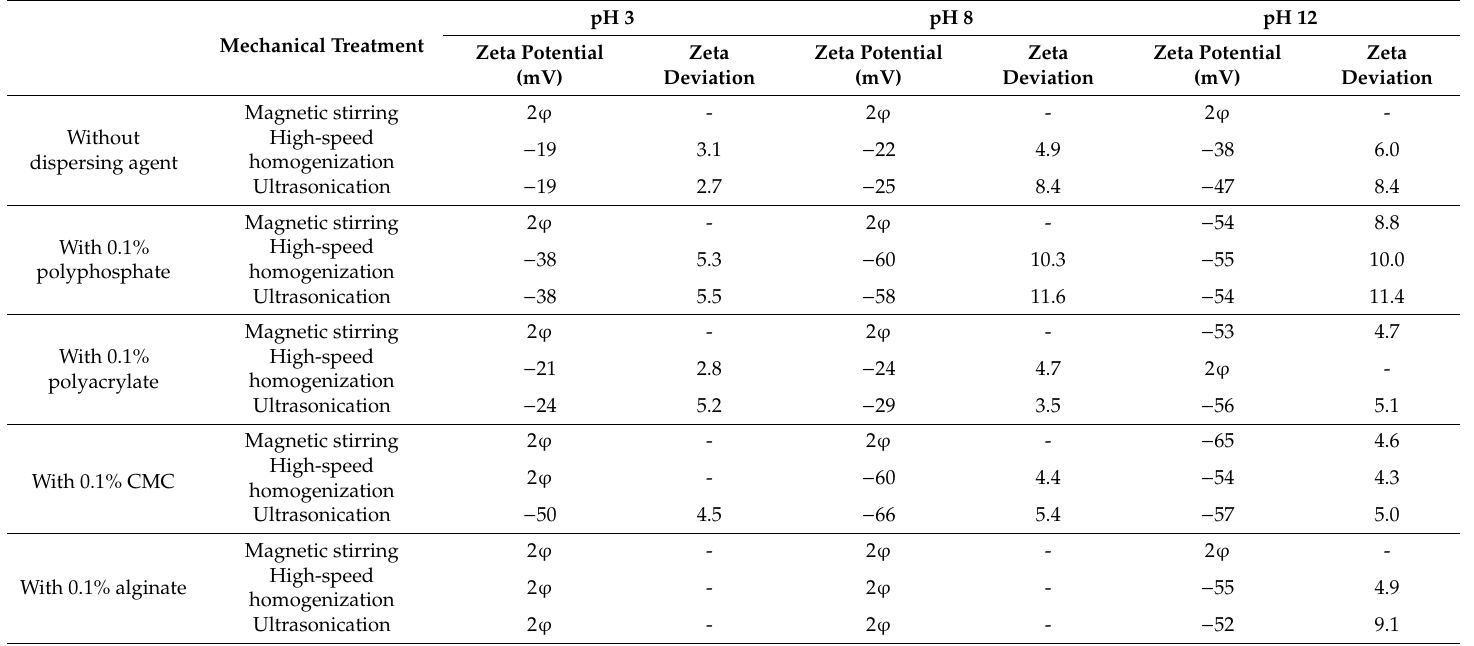
Table A2. Zeta potential values for sepiolite 2 suspensions as a function of the di ff erent conditions